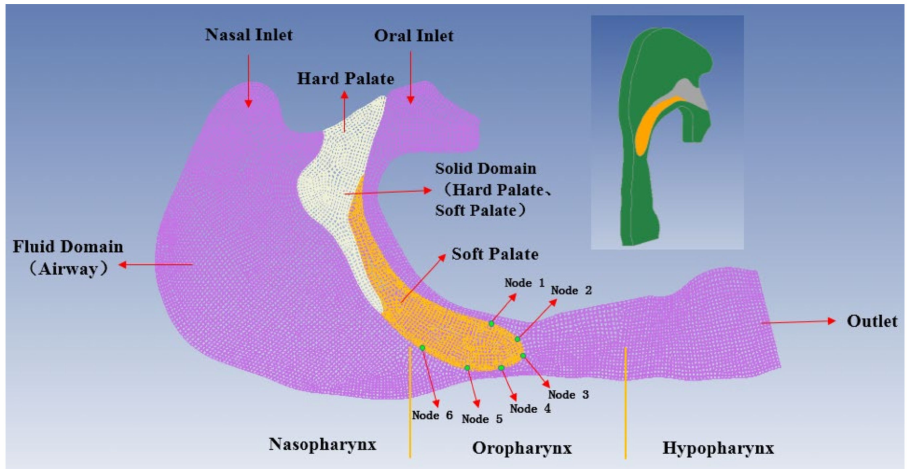
Figure 3. The FE model of the fluid field of the upper airway, along with the solid fields of the soft and hard palates.